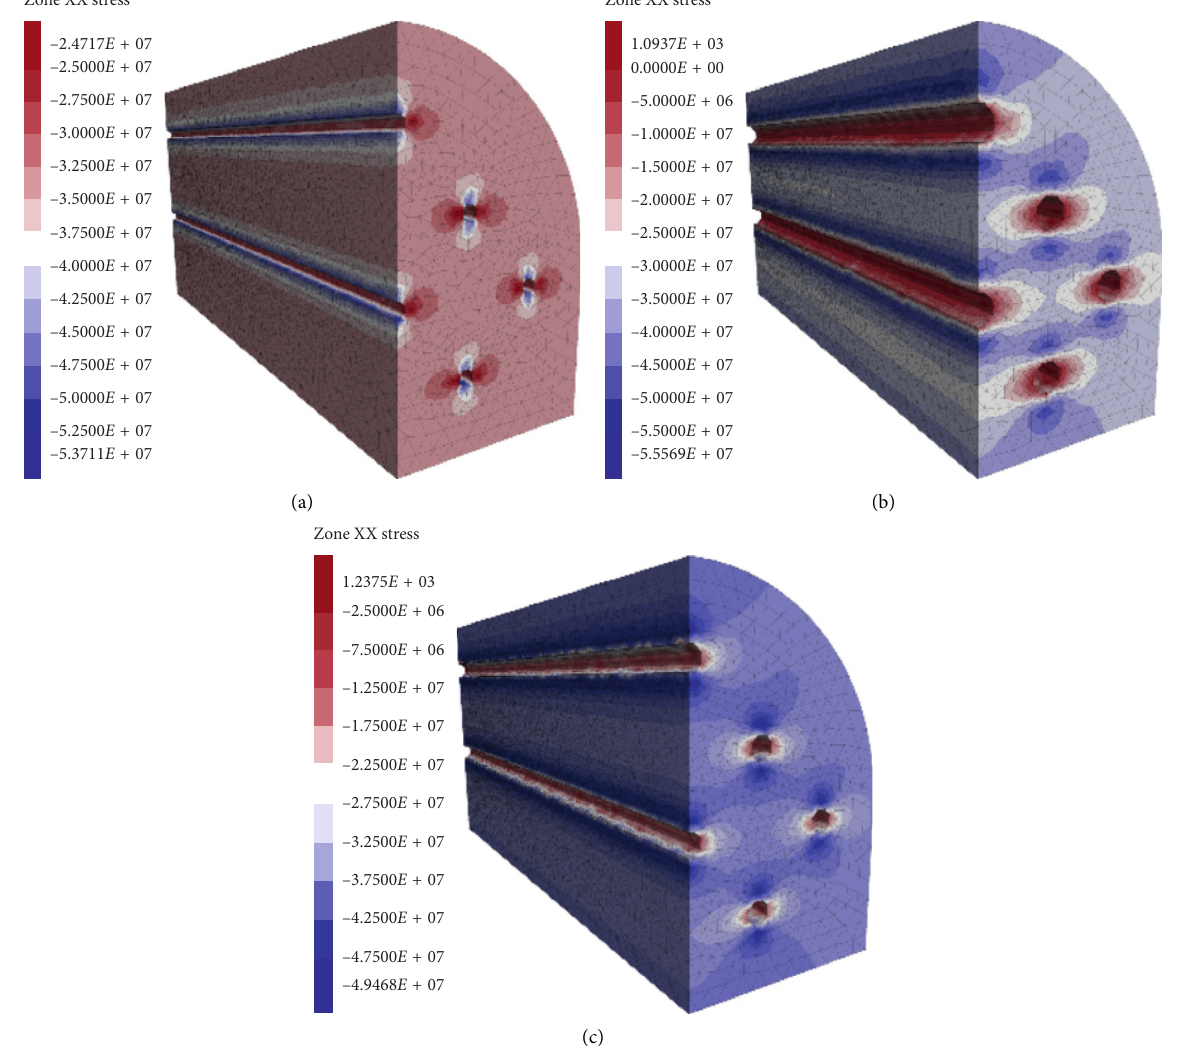
Figure 8: Horizontal stresses of pressure relief boreholes. (a) Φ 100mm. (b) Φ 200mm. (c) Φ